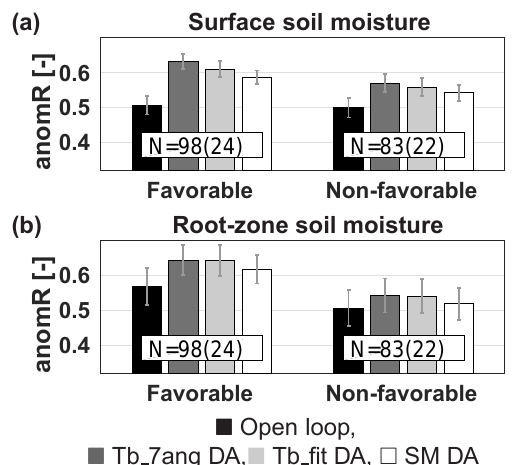
Figure 9. Performance of open-loop and data assimilation experi- ments in terms of anomaly correlations (anomR) calculated across 3h analyses and forecast time steps from 1 July 2010 to 1 May 2015 for (a) surface and (b) root-zone soil moisture. The bars show skill metrics averaged over sites in either favorable or non-favorable ar- eas, where favorable areas refer to the areas indicated by the gray background shading in Fig. 8. The variable N is the total number of SCAN and USCRN sites considered for each category, with the number of clusters in parentheses. The error bars reflect cluster- averaged 95% confidence